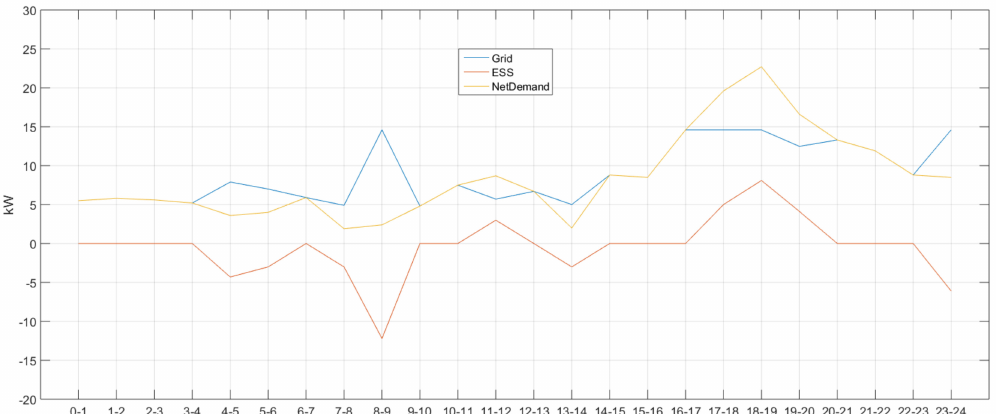
Figure 5. Simulation result when the conditional equation for system power flattening (power use) was